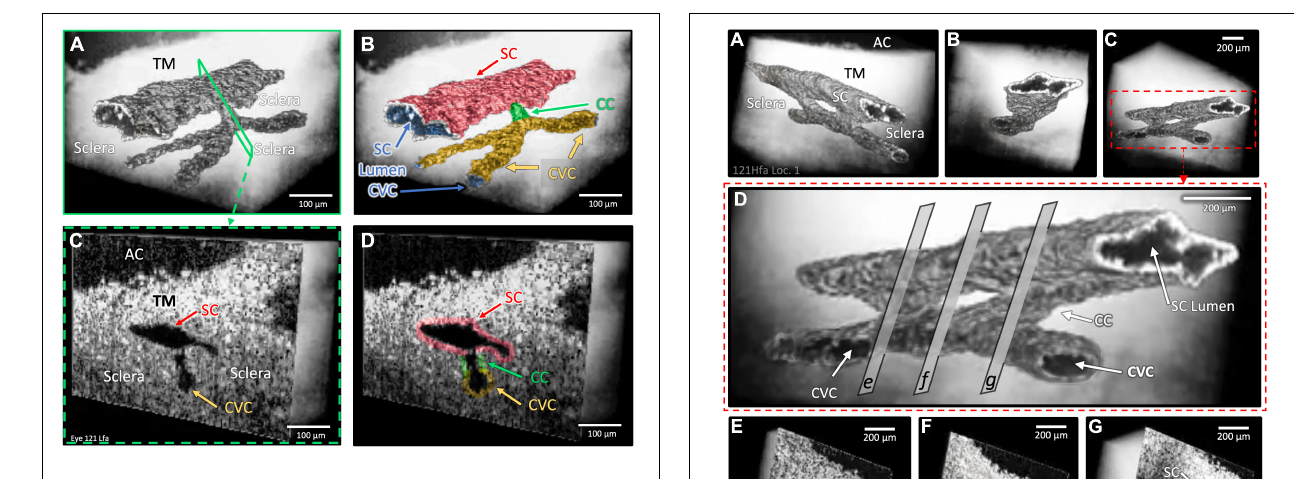
FIGURE 3 | One collector channel: Architecture and internal relationships. Images (A,B) demonstrate the architecture of outflow structures obtained after segmentation of the lumens (dark appearance) visible in the OCT images. Cross-sections in (C,D) explore internal structure at a CC exiting SC that communicates with a CVC at the location of the blue slice in (A) and green outline in the color map in (B) . The lumen of the CC is a short segment oriented perpendicular to both SC and the CVC lumen. The SC and CVC lumens are oriented parallel to each other. SC, CC, and CVC lumen experience synchronous pressure-dependent compression and distention ( Supplementary Video 2 ).